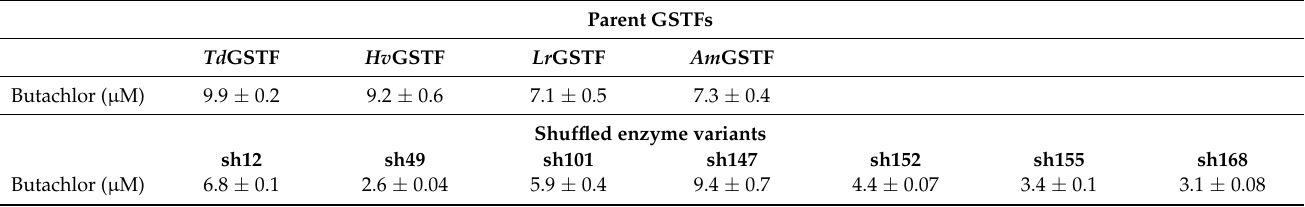
Table 2. Summary of IC 50 values for butachlor on the parent GSTFs and enzyme variants. The data represent the mean ± SD (N =